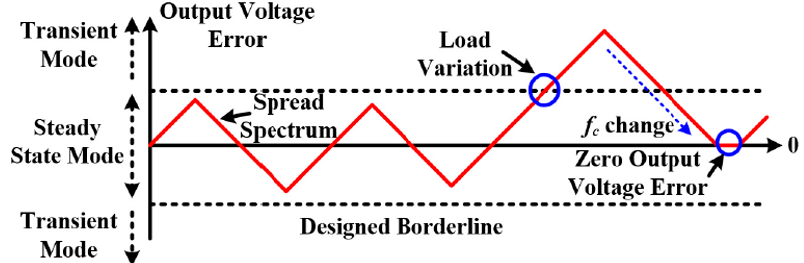
Figure 17. Pulse frequency modulation (PFM) and PSM hybrid control algorithm shown in [51].